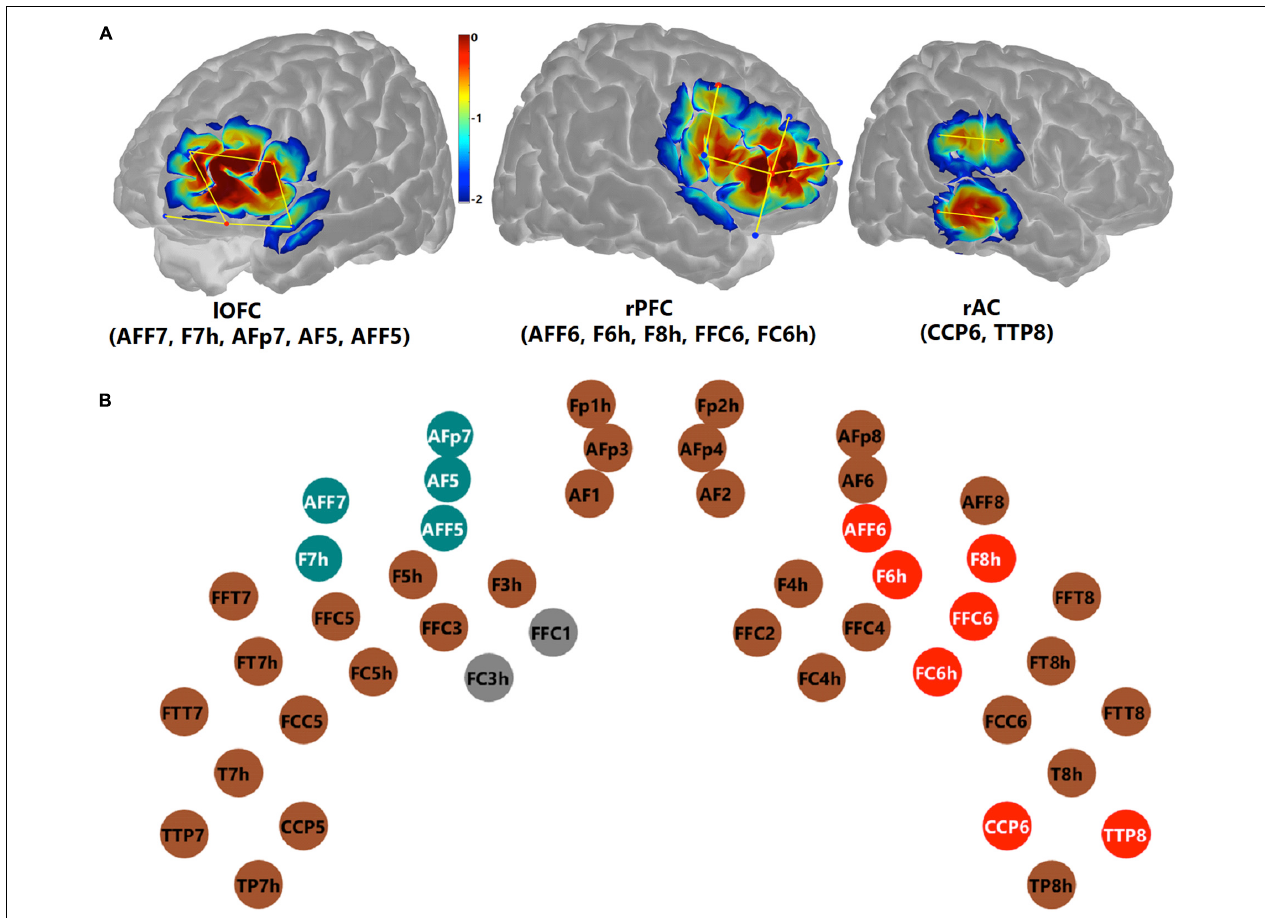
FIGURE 9 | Functional near-infrared spectroscopy measures that revealed inhibitory control. Panel (A) shows the channels comprising three ROIs, on the left orbitofrontal cortex (lOFC), the right prefrontal cortex (rPFC), and the right auditory cortex (rAC). The colors are the sensitivity profiles, in log10 mm - 1 units, generated from AtlasViewer (Aasted et al., 2015). Panel (B) shows montage and marks the channels (dots) which showed a significant effect of inhibitory control. (cid:49) HbO amplitudes in the intra-incongruence period in the teal channels (lOFC) showed a significantly age-dependent effect of inhibitory control. Channels in red showed a significant effect of inhibitory control in the post-incongruent period. Channels in brown showed no significant effect. Channels in gray (FFC1 and FC3h) were excluded from further analyses due to poor data